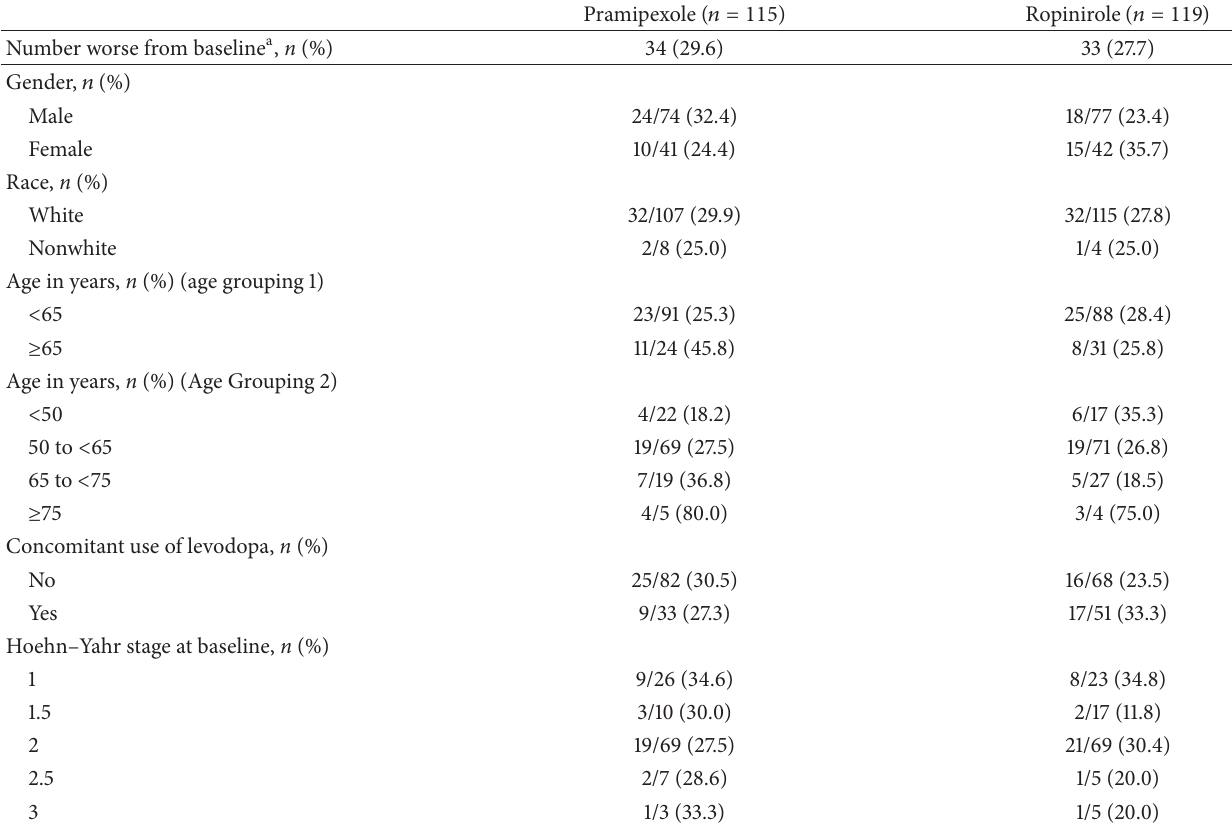
Table 5: Subgroup analysis: summary of Expert Panel’s comprehensive ophthalmology assessment (COA) following 2 years on study drug (full analysis set, last observation carried forward [LOCF]). Shown are numbers of patients in each subgroup assessed to have worsening from baseline on the COA, as defined in the legend of Table 4/number of patients in each subgroup within each treatment